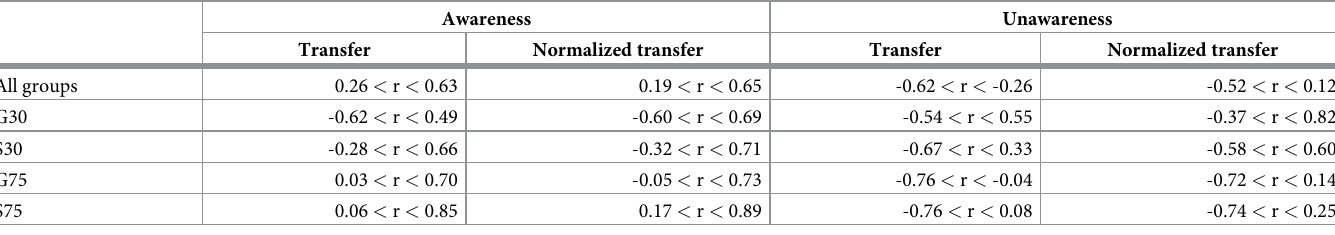
Table 3. Results of correlations between awareness or unawareness and intermanual